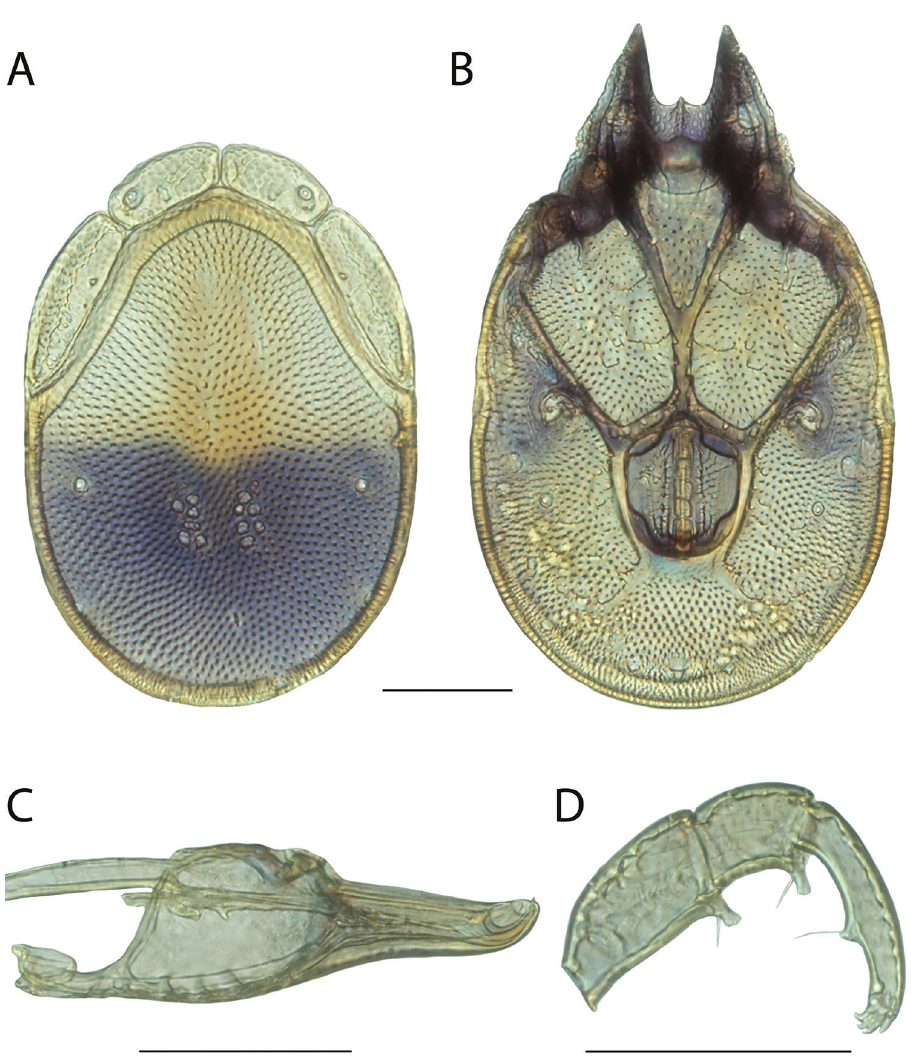
Figure 248. Torrenticola solisorta sp. n. male: A dorsal plates, note the faint orange coloration, which is a rare character state (most specimens are much brighter), not a male character B venter (legs removed) C subcapitulum D pedipalp (setae not accurately depicted). Scale = 100 µm.